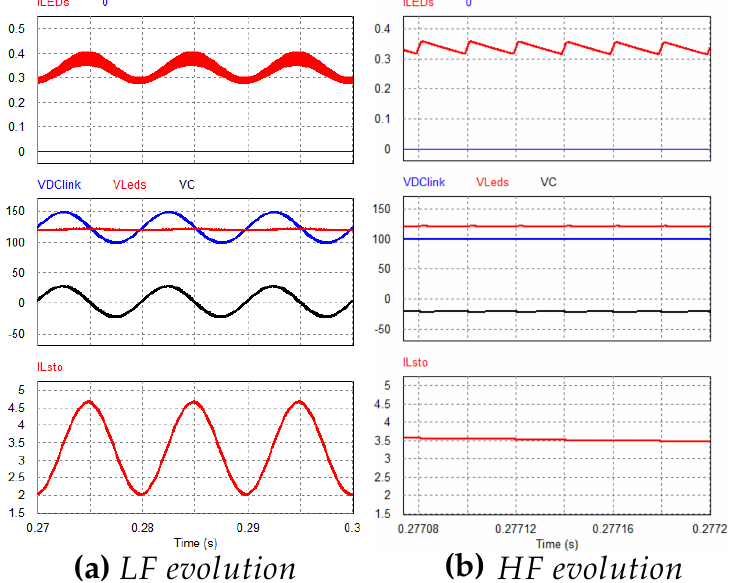
Figure 8. Simulation results for full power operation in open loop ( L = 3